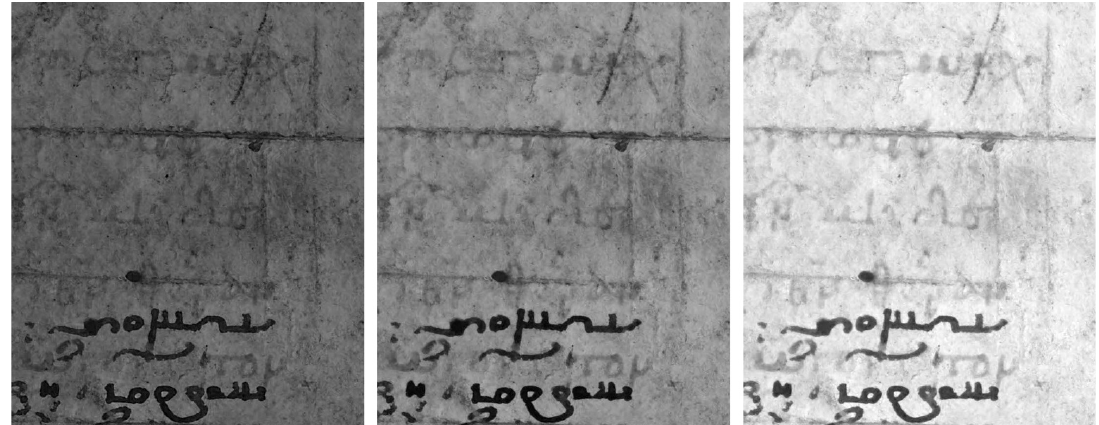
Figure 4. Trinity College Cambridge MS. O.9.27: fragment of the Red, Green and Blue channels respectively, in UV light. Used with permission from the Master and Fellows of Trinity College